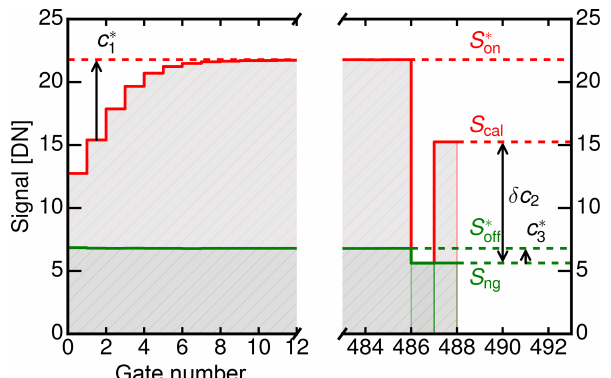
Figure 2. Total received signal S in digital numbers as a function of gate number with external noise source switched on ( S ∗ on , red) and switched off ( S ∗ , green). The two last gates monitor the signals off S ng and S cal , which correspond to the receiver noise and the internal calibration source. The factors c ∗ , c 2 and c ∗ correct the estimated 1 3 noise power P † n to reflect the actual receiver sensitivity P n . Signal levels obtained only during the calibration with the external noise source are marked with an